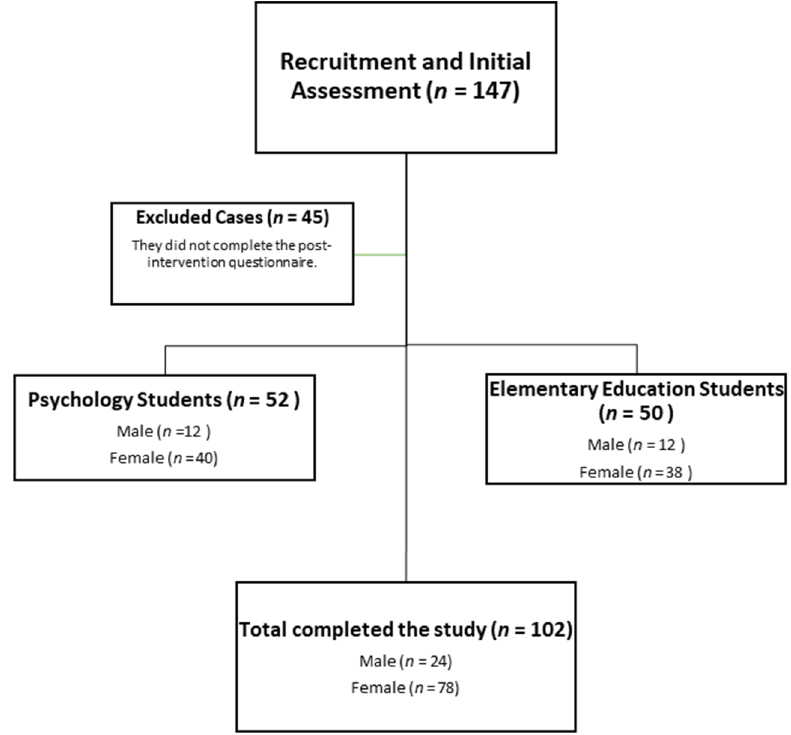
Figure 2. CONSORT flowchart of recruited students.